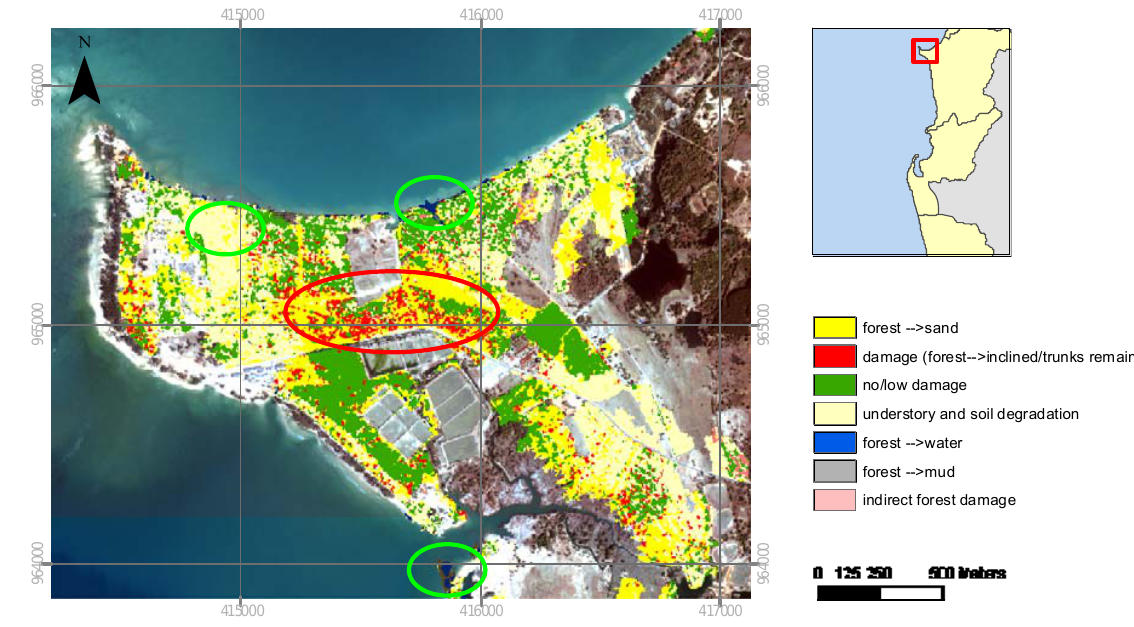
Fig. 14. Human induced land use changes versus tsunami induced changes illustrated for coconut plantation near Pakarang Cape (Khao Lak). Change detection results are based on DMC. Human induced land use changes in the hinterland are highlighted in red, whereas tsunami induced changes near the coast are highlighted in green.